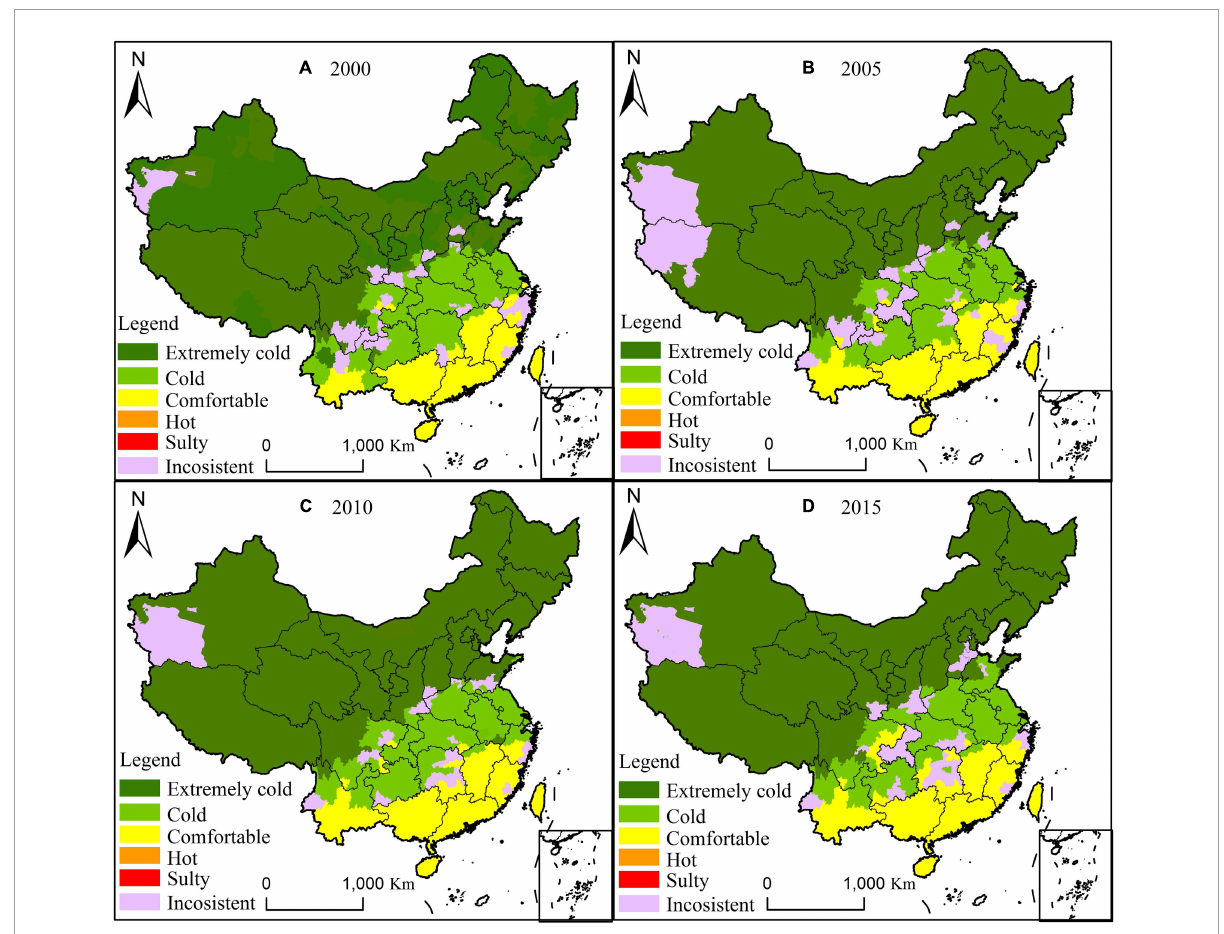
FIGURE2 Annual change in climate comfort of human settlement environment in China from 2000 to